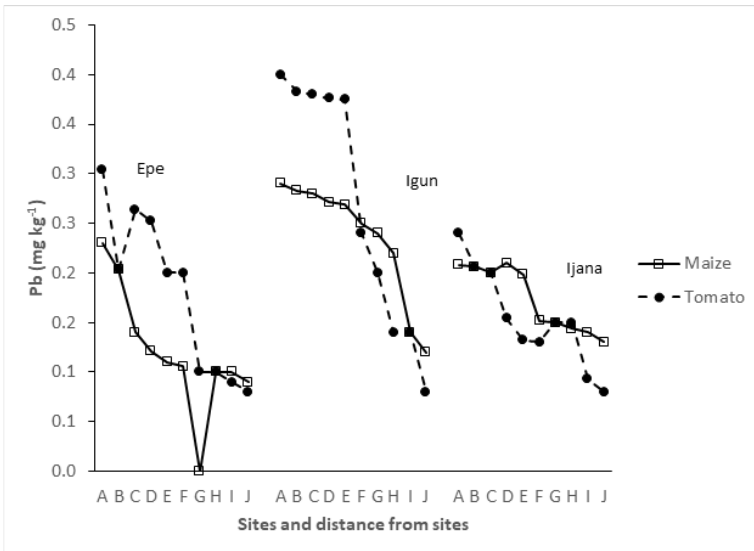
Figure 6: Concentrations of Pb in maize and tomato crops at Epe, Igun & Ijana (0 – 900 m) sites. A = 0 m from site; B = 100 m from site; C = 200 m from site; D = 300 m from site; E = 400 m from site; F = 500 m from site; G = 600 m from site; H = 700 m from site; I = 800 m from site; J = 900 m from site